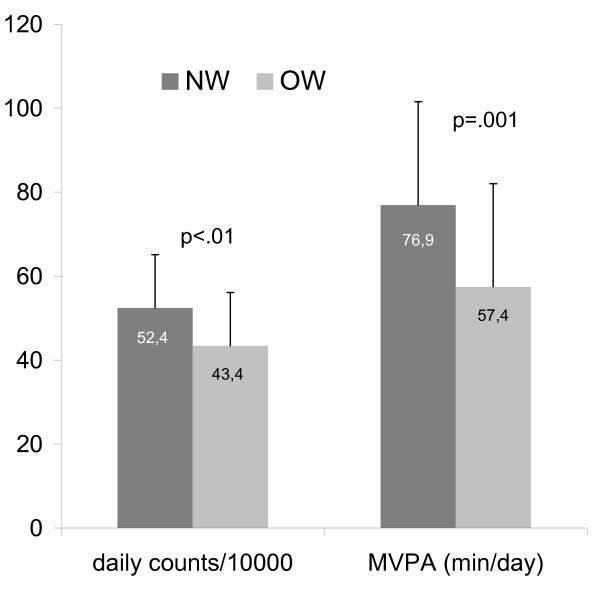
Degree of physical activity in NW and OW children.